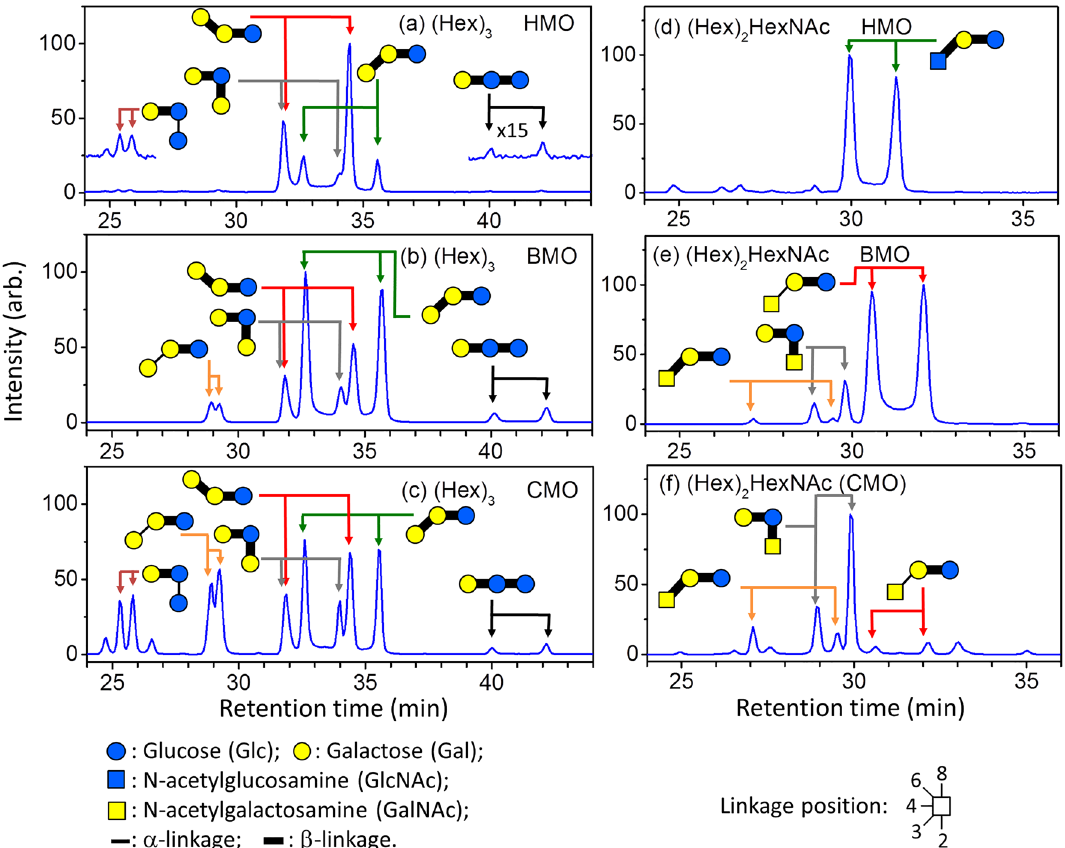
Figure 1. PGC chromatograms of oligosaccharides separated using a PGC column from a fraction of eluents separated using an amide-80 column for human milk oligosaccharides (HMO), bovine milk oligosaccharides (BMO), or caprine milk oligosaccharides (CMO). ( a–c ) ion m/z 527 (Hex) 3 sodium adducts, and ( d–f ) ion m/z 568 (Hex) 2 HexNAc sodium